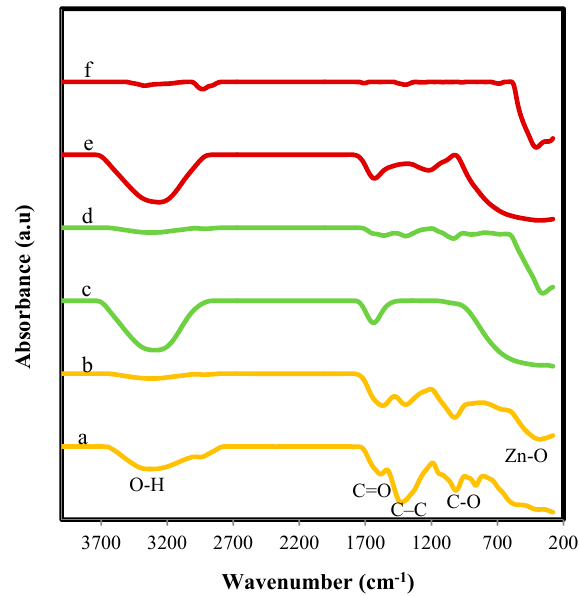
Figure 5. FTIR spectra of ( a ) fruit extract; ( b ) ZnO-F; ( c ) pulp extract; ( d ) ZnO-P; ( e ) seed extract and ( f ) ZnO-S.